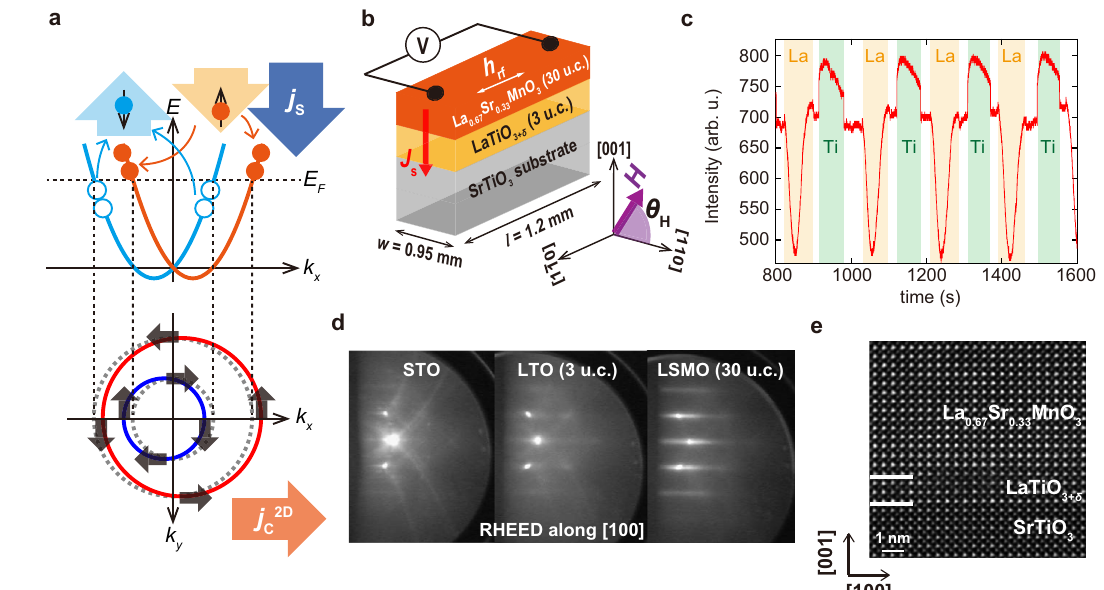
Fig. 1 | Sample structure and characterizations. a Schematic illustration of the inverse Edelstein effect in a single parabolic band model. RSOI resolves the spin degeneracy of the electronic band and splits it into up- and down-spin bands (orange and blue curves). The Fermi surface splits into large and small circles with opposite spin chirality (arrows). When a spin current is injected into these bands, the chemical potential of the up-spin electrons increases ( fi lled orange circles), whilethatofthedown-spinelectronsdecreases(openbluecircles)(top fi gureof a ). Thus, the large and small Fermi surfaces shift in opposite directions. Due to the difference in the size of the circles, the movement of the outer circle is dominant,